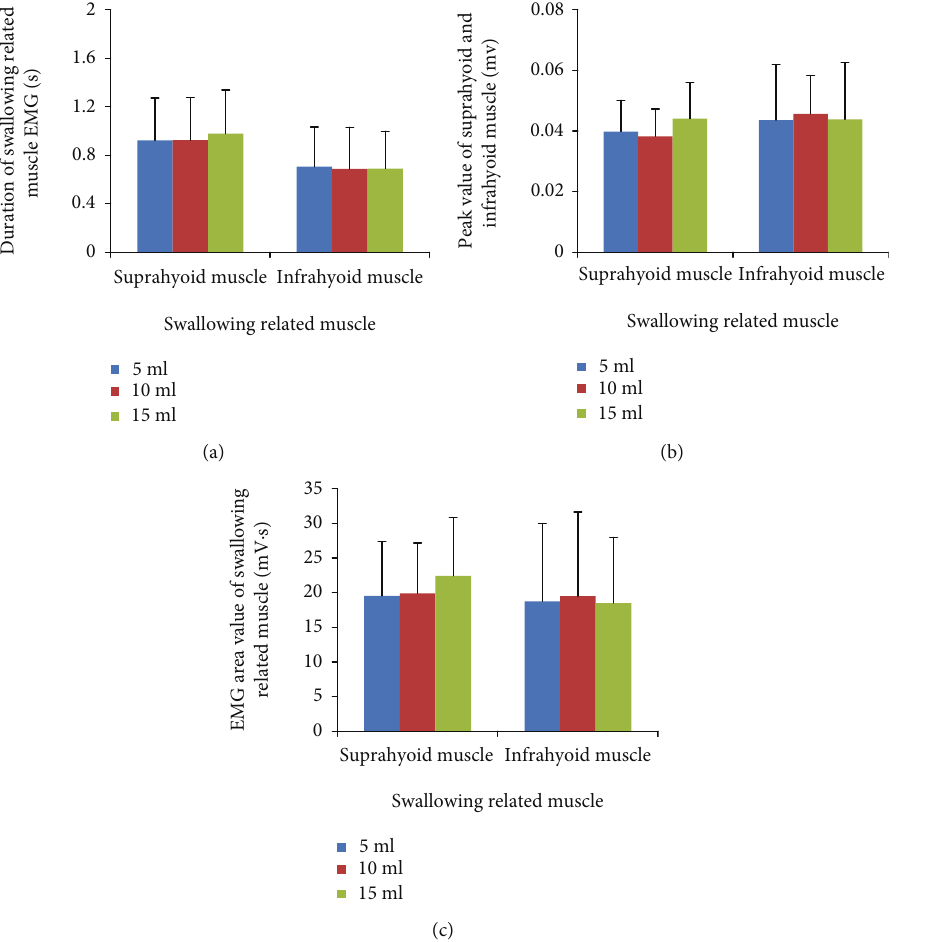
Figure 4: E ff ects of bolus volume on swallowing-related muscles parameters. (a) Duration of swallowing-related muscle. (b) Peak value of swallowing-related muscle. (c) EMG burst area of swallowing-related muscle. Data were expressed as the mean ± standard deviation